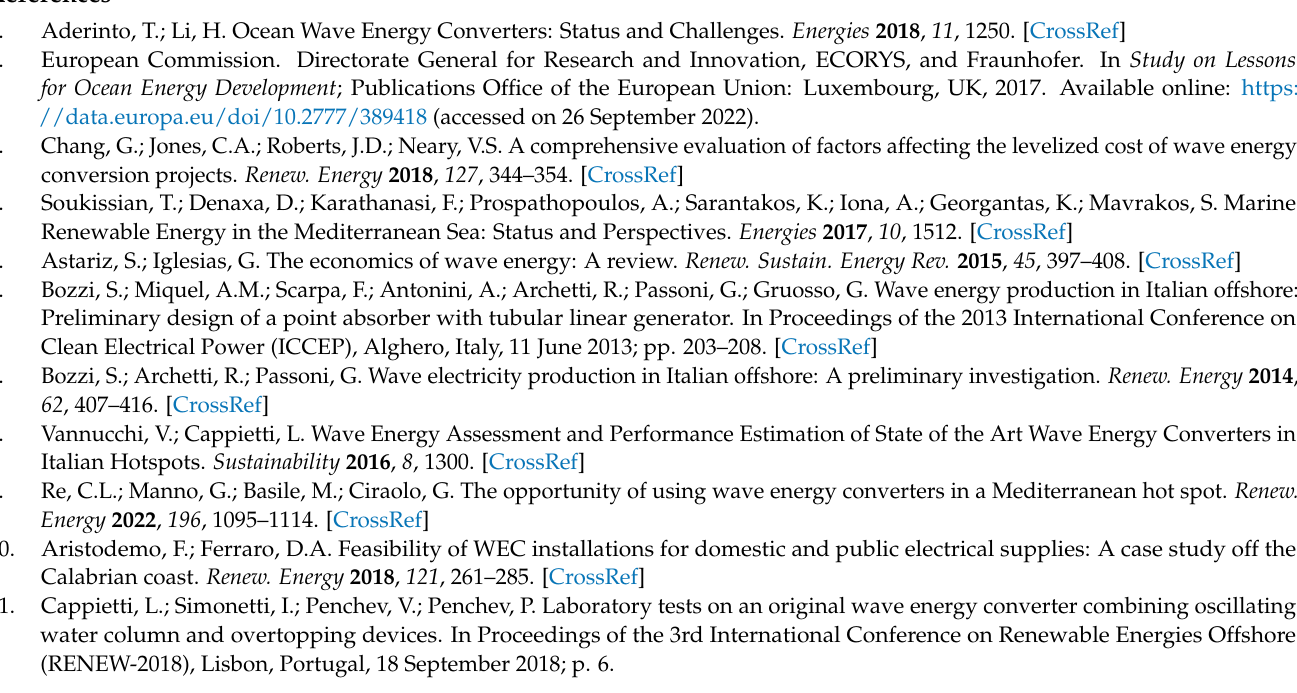
Figure A2. Capture width of the overtopping-based component of the device, CW II , as a function of the width of the OWC chamber, W / L , for different sizes of the aperture in the back wall relative to the incident wave height G / H = 0.167 ( a ), 0.33 ( b ), 0.5 ( c ), 0.67 ( d ), 0.83 ( e ), 0.1 ( f ). Results obtained with the wave height H / h = 0.27.